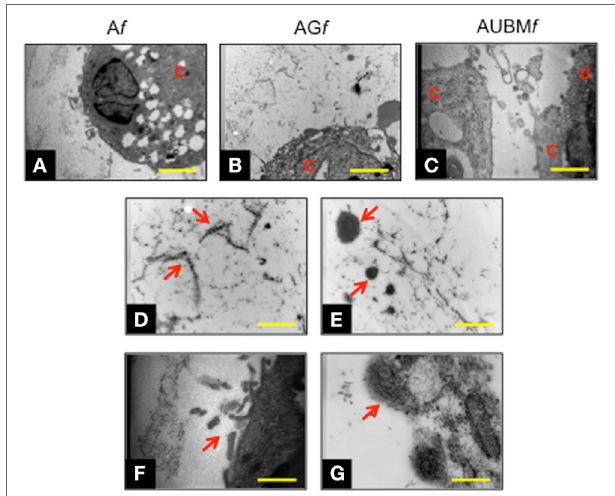
FigUre 5 | Chondrogenic properties of A f , AG f , and AUBM f embedded cells: transmission electronic microscope ultrastructural analysis at day 14 of culture. Lower magnification photomicrographs showed the ultrastructure of an embedded redifferentiated chondrocyte in A f (a) , AG f (B) , and AUBM f (c) . In the images at higher magnification, red arrows indicated the presence of ECM dense material and collagen fibers with their typical banding pattern in the pericellular space (D,e) and evidenced the ECM-containing vesicles release from embedded cells (F,g) . Bar corresponds to 2.6 µm in a-c, 1 µm in (D–F) and 0.4 µm in grams. C, cell; U,